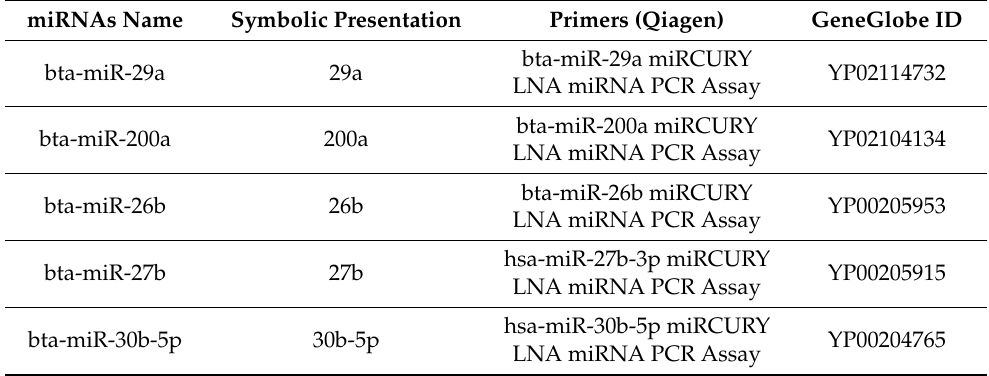
Table 2. Primer information of internal control miRNA candidates in bovine milk